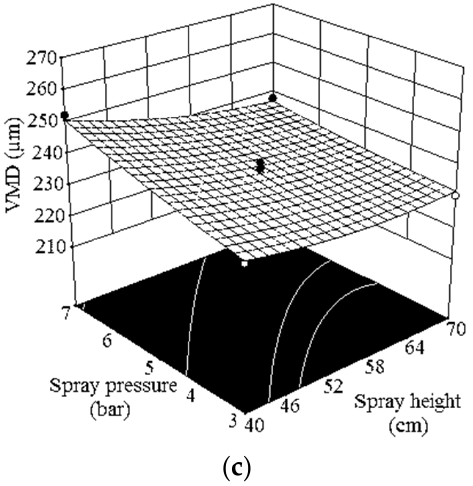
Figure 12. Three-dimensional surface map for VMD: ( a ) interaction effect of forward speed and spray height at 5 bar pressure; ( b ) interaction effect of forward speed and spray pressure at 55 cm height; ( c ) interaction effect of spray height and spray pressure at 6 km/h speed.